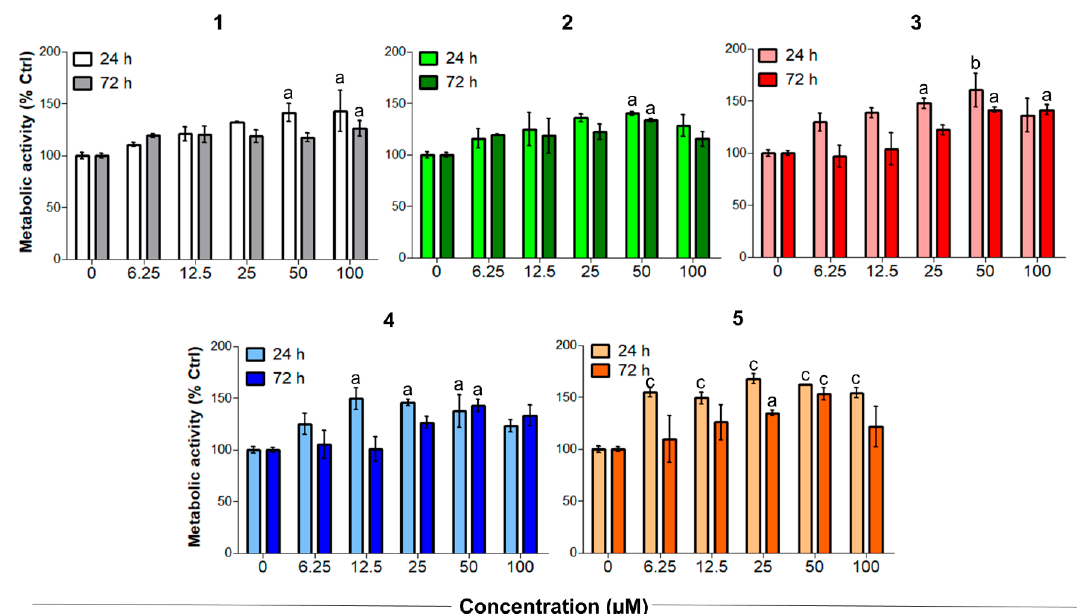
Figure 4. Metabolic activity of human primary tendon-derived cells exposed to increasing concentrations of CORMs (compounds 1 – 5 ) after 24 and 72 h. The control sample (0 µ M = cells treated with DMSO 0.1%) is set as 100%. a = p < 0.01; b = p < 0.001; c = p < 0.0001 between cells treated with CORMs and the control sample.